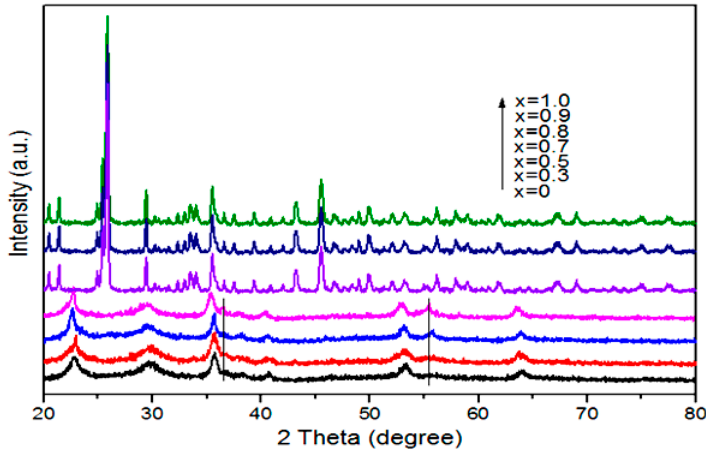
Figure 1. XRD patterns of nanoparticles prepared by hydrothermal method at 180 ◦